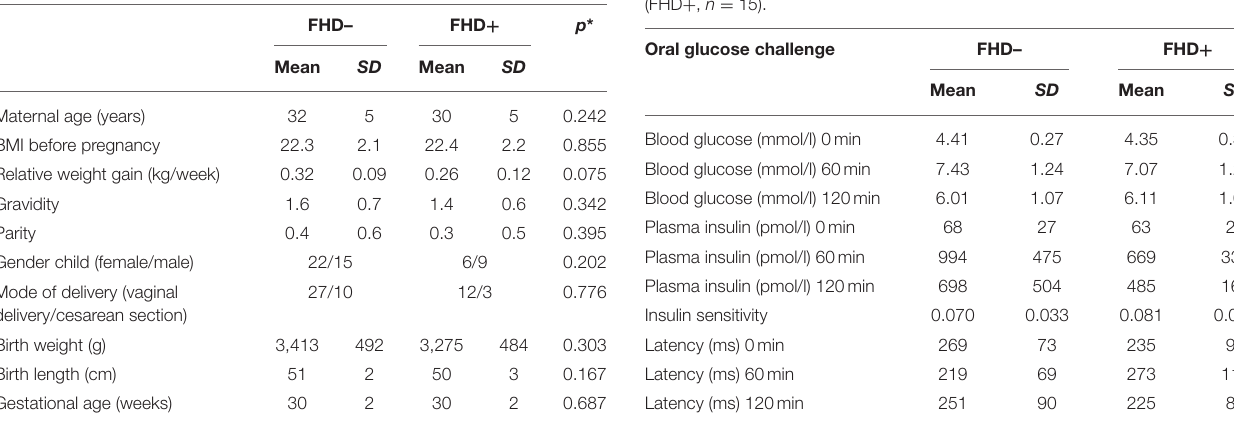
TABLE 2 | Descriptives and comparison of the two subgroups with a negative family history of diabetes (FHD–, n = 37) and a positive family history of diabetes (FHD + , n =